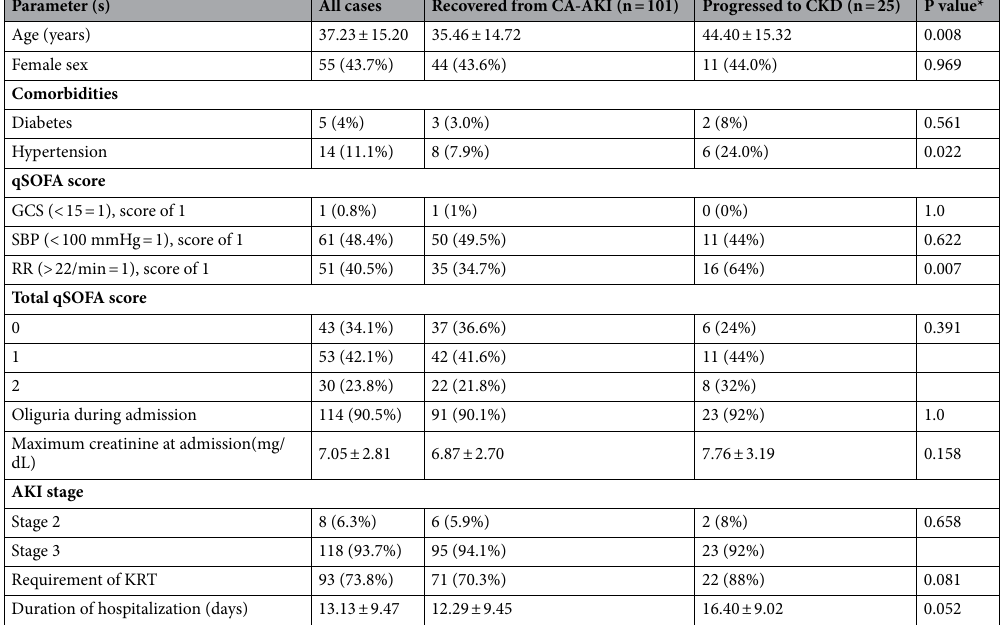
Table 1. Baseline patient characteristics in the study participants. Data presented as mean ± standard deviation and number (percentage). *p-value for comparison between patients recovered and progressed to CKD from CA-AKI. qSOFA Quick sequential organ failure assessment score, GCS Glasgow coma scale, SBP Systolic blood pressure, RR Respiratory rate, KRT Kidney replacement therapy (all were haemodialysis).